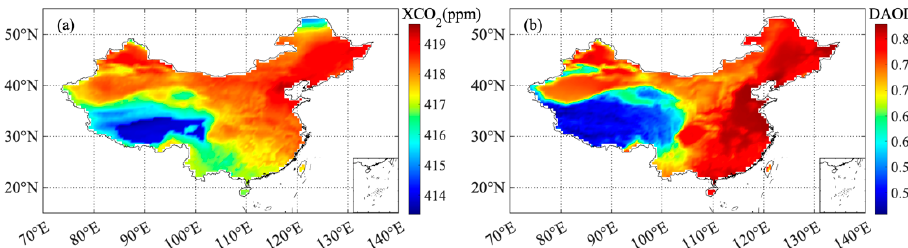
Figure 11. The distribution of XCO 2 and DAOD simulations over China on 10 April 2021: ( a ) XCO 2 and ( b ) DAOD simulations of IPDA lidar over China, with colors representing different values.